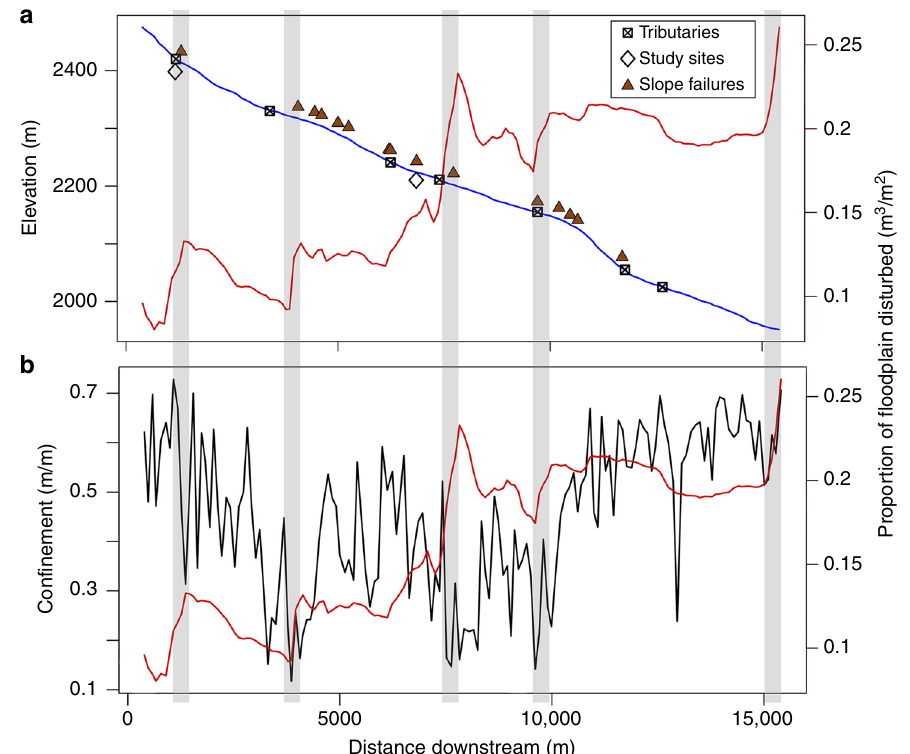
Fig. 6 Observations of 2013 fl ood from lidar analysis. Proportion of disturbed fl oodplain (cumulative volume displaced divided by cumulative fl oodplain area) with increasing distance downstream along North Saint Vrain Creek is indicated by the red lines ( a , b ). The location of tributary junctions, fi eld study sites, and slope failures are indicated along the blue line, which indicates decreasing elevation ( a ). Changes in valley con fi nement measured at 155 study reaches along North Saint Vrain Creek are indicated by the black line ( b ). Shaded areas indicate regions of increasing fl oodplain disturbance, commonly coinciding with decreases in valley con fi nement, tributary junctions, and slope failures, at which deposition of sediment was the dominant response. Source data are provided as a Source Data fi